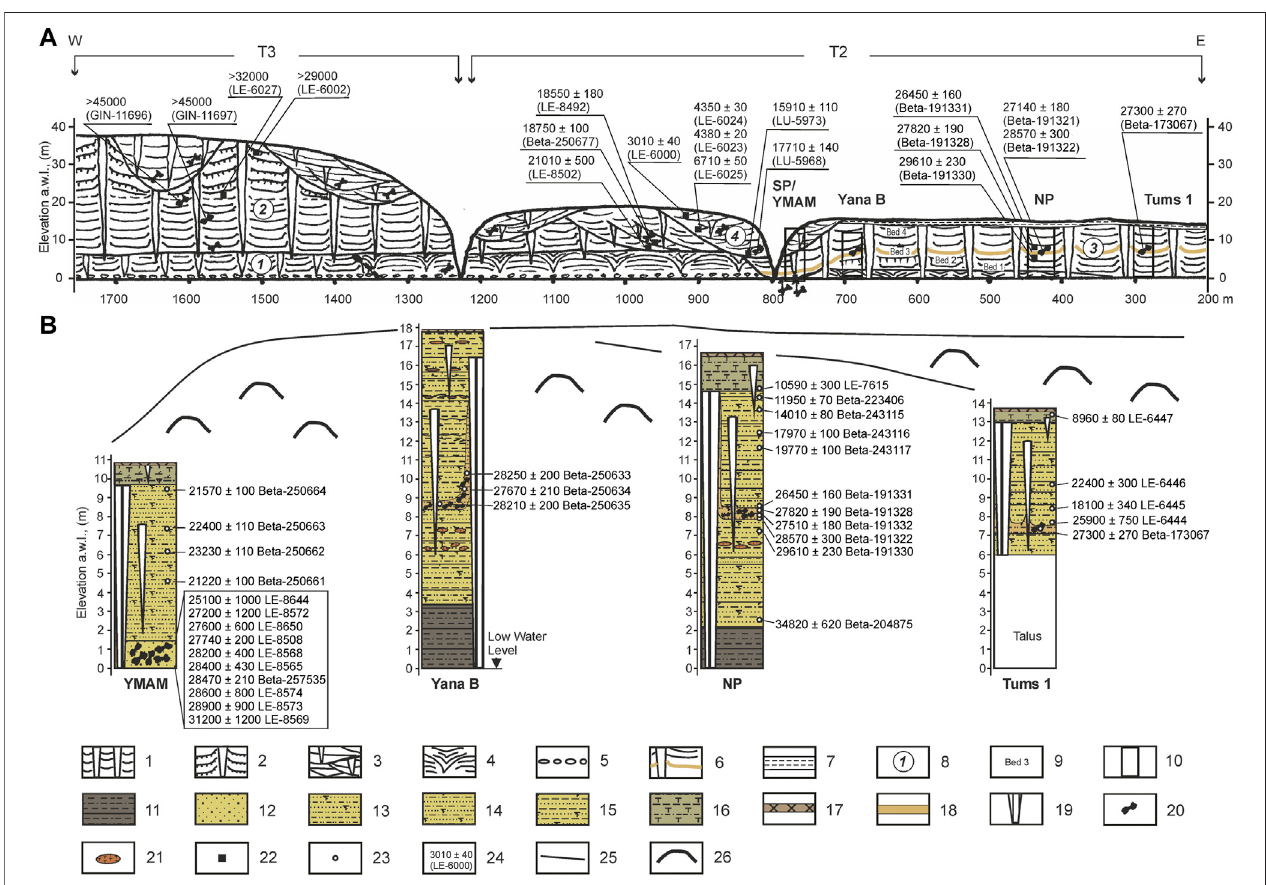
FIGURE 5 | Overview of the geology of the Yana complex of sites. Soplivaya Gora (Yana-195) reference pro fi le of Quaternary deposits (A) and cryolithology for different localities within the Yana RHS – YMAM, Yana B, Northern Point, TUMS 1 (B) . Illustration key: 1 — Ice Complex deposits of different geological age, with syncryogenic ice wedges in alluvial and proluvial deposits; 2 — aeolian deposits; 3 — cross bedding; 4 — ice-wedge cast; 5 — conglomerates; 6 — position of the Upper Paleolithic Yana RHS cultural layer; 7 — deposits of the Holocene cover complex; 8 — number for geological Member; 9 — bed number within the Member 3; 10 — location of cryolithological pro fi les; 11 — interbedding of clays, silts, and clayey silts; 12 — sand with small pebbles; 13 — sandy silt; 14 — clayey-sandy silt; 15 — sandy-clayey silt; 16 — interbedding of clayey silt bands and sandy-clayey silt with beds and lenses of peat; 17 — active layer; 18 — cultural layer in situ ; 19 — polygonalicewedges;20 — positionofPleistoceneanimalboneswithinthedeposits;21 — peatlens;22 — positionof 14 S samplesonthegeologicalpro fi le (A) (plant remains dated); 23 — position 14 C samples within local cryolithological pro fi les (B) ; 24 — radiocarbon date and lab code; 25 — terrace edge (schematic); 26 — permafrost mound (baidzharakh) — cone-shaped land forms resulted from partial thawing of polygonal ice-wedge